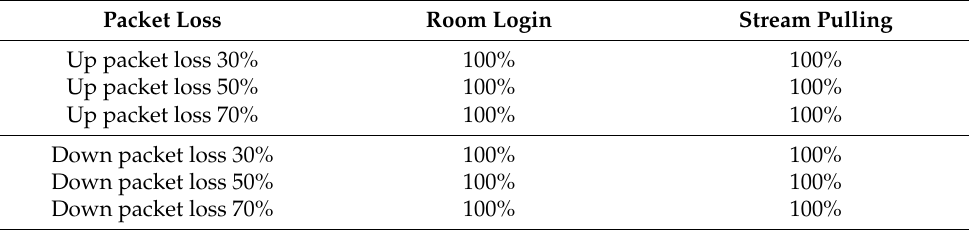
Table 3. Room login and pull stream situation.